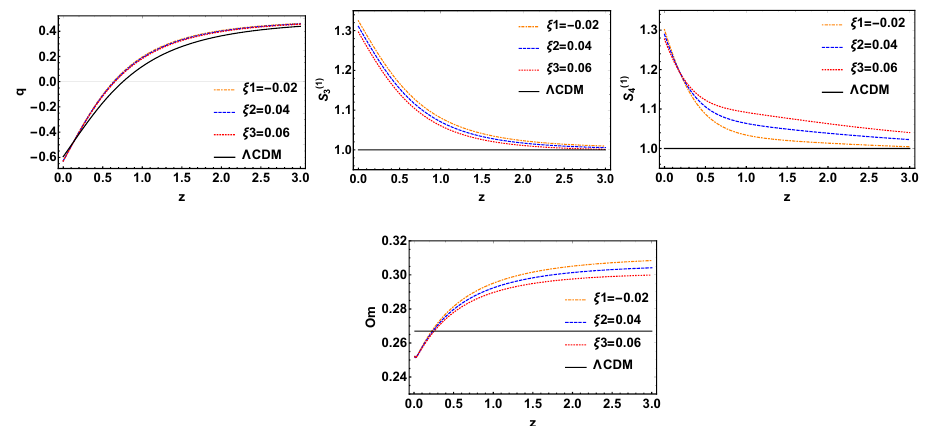
( 1 ) ( 1 ) , S and Om , respectively, versus red shift z for the 3 4